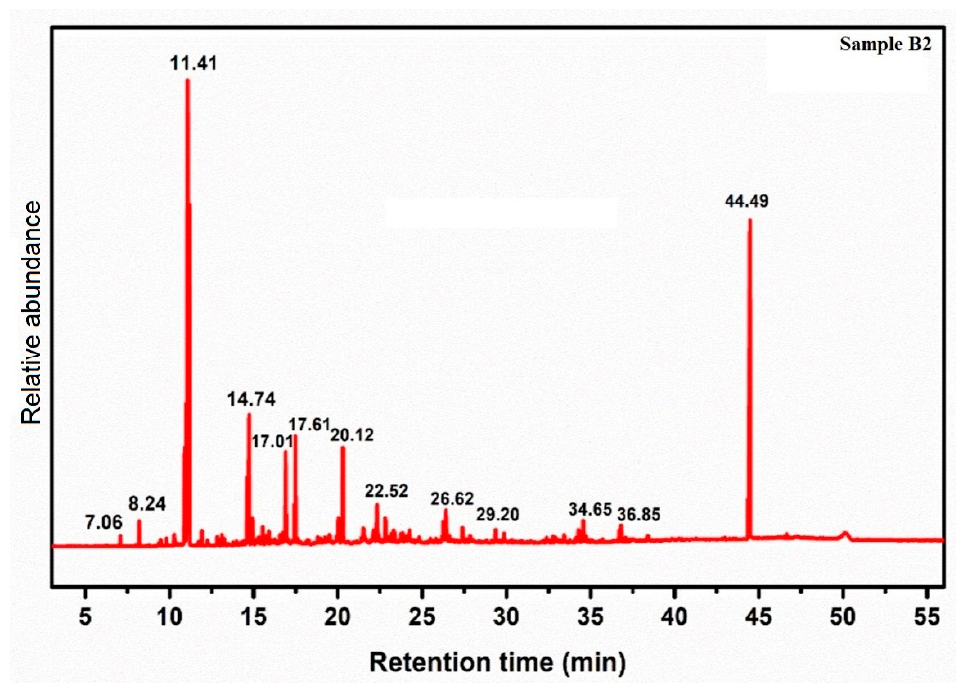
Figure 4. GC-MS analysis of sample B2.